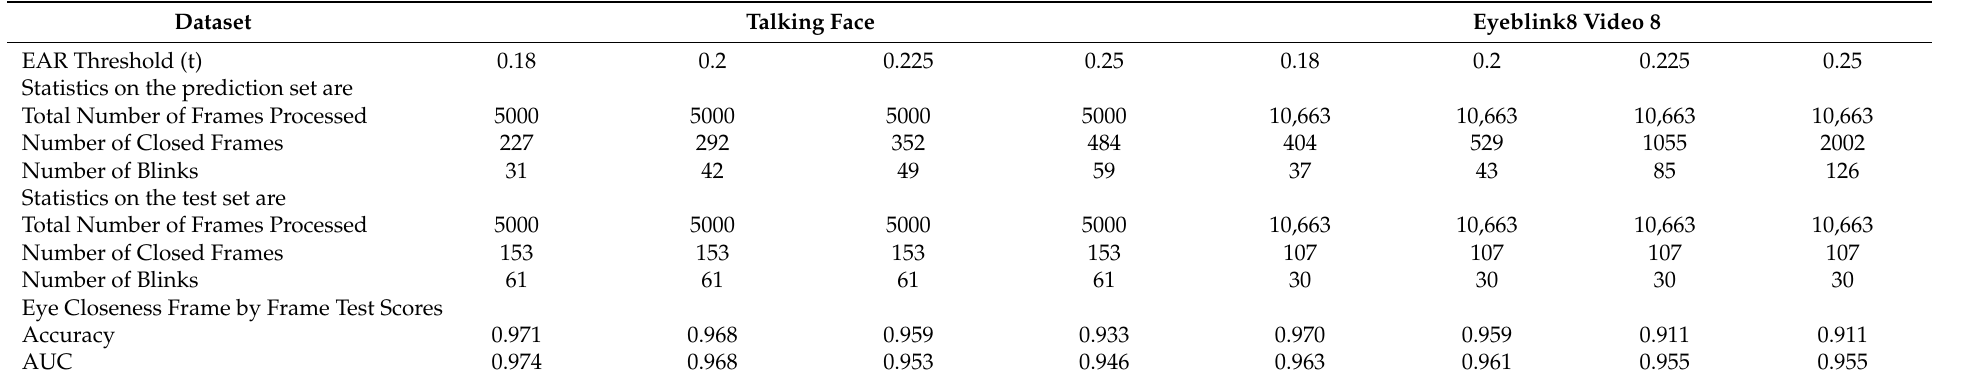
Table 4. Statistics on prediction and test (Talking Face and Eyeblink8